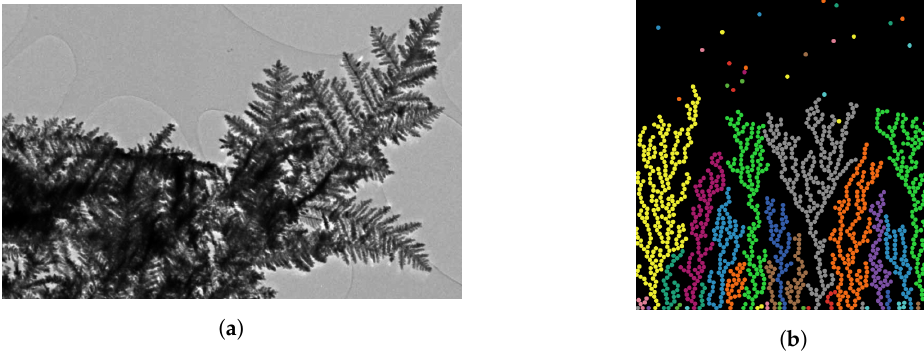
Figure A4. Comparison between dendritic growth in silver ion materials and Diffusion-Limited- Aggregation simulated using NetLogo. ( a ) dendritic growth in silver ion at the micro meter scale, reproduced with permission from [190]; ( b ) diffusion-limited-aggregation simulated using